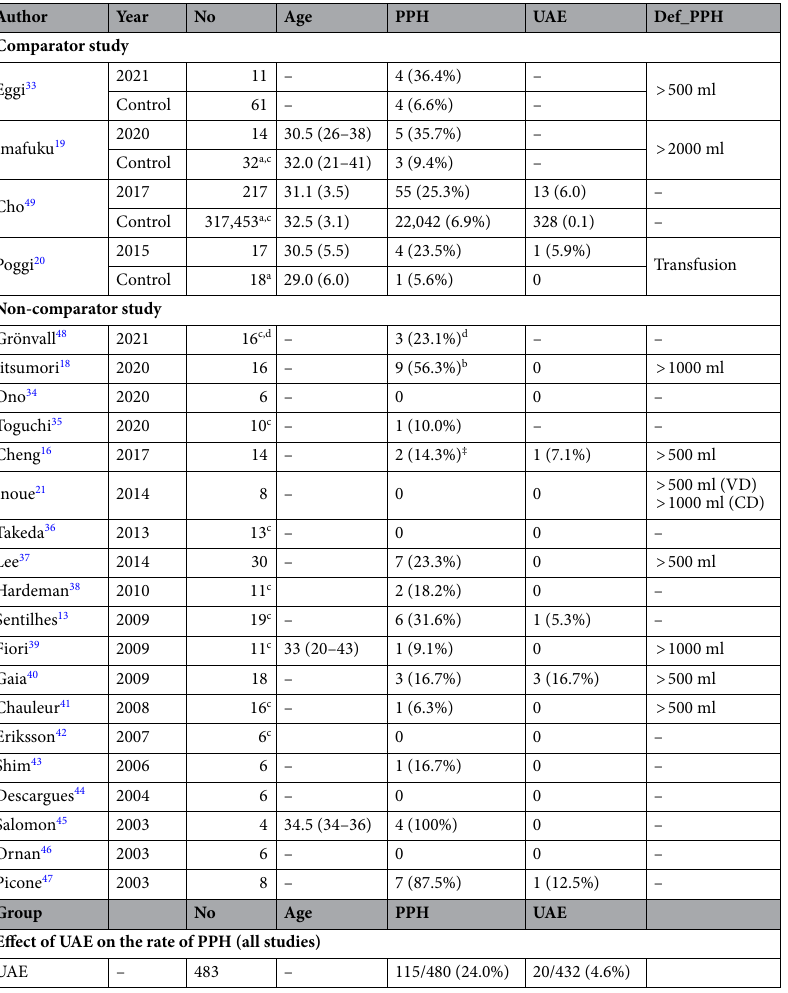
Table 2. Summary of the rate of PPH in subsequent pregnancies after UAE. Median (range) or mean (standard deviation) or number (percentage per column) are shown. UAE uterine artery embolization, VD vaginal delivery, CD cesarean delivery, No . number of prior uterine embolization cases, Indi indication, PPH postpartum hemorrhage, Def_PPH definition of postpartum hemorrhage, Type type of uterine artery embolization. a Women without prior UAE. b Unpublished data. c Some patients had multiple deliveries. d PPH recurred in three of the 13 women (23.1%). Some values listed above might be slightly different from the original ones due to the estimation procedure used by the